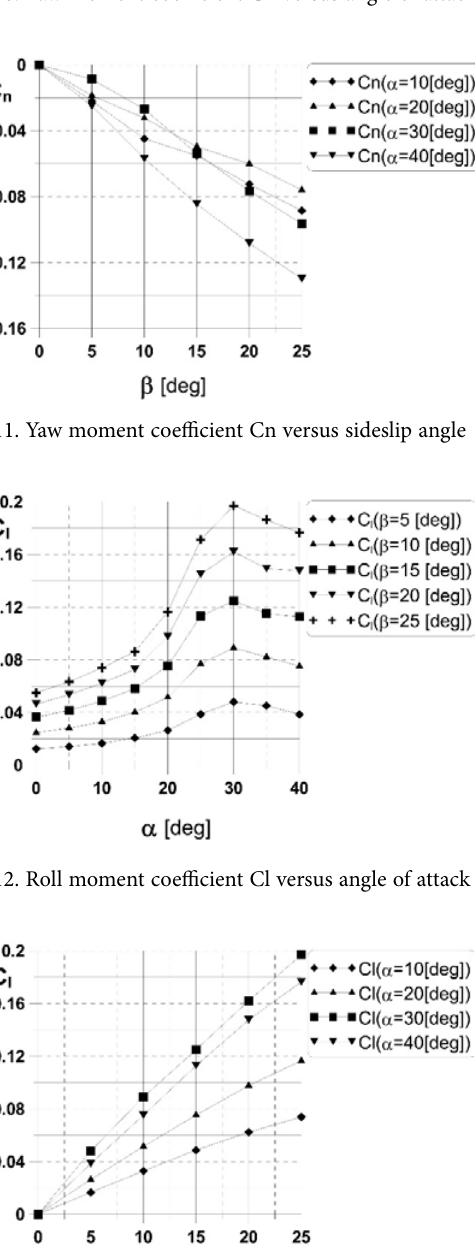
Fig. 10. Yaw moment coefficient Cn versus angle of attack